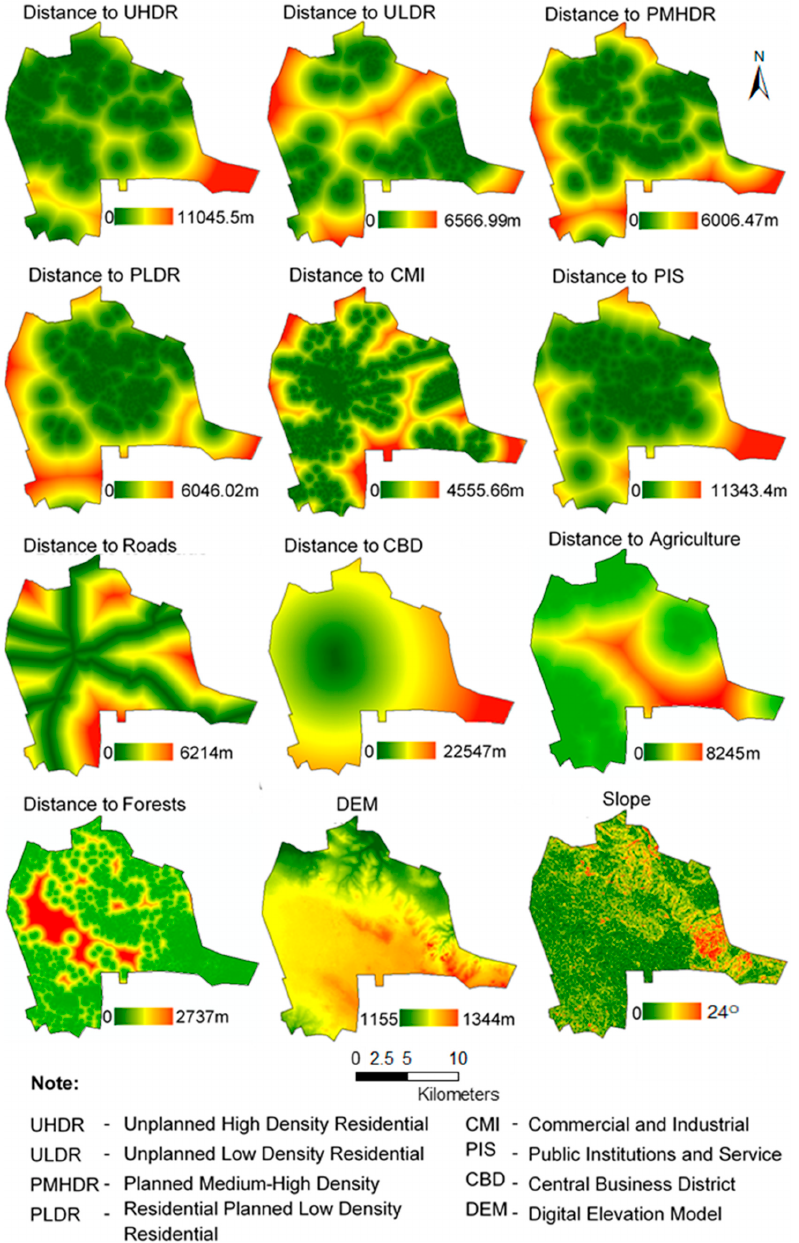
Figure 3. Model driver variables for the intra-urban land-use expansion of Lusaka city for the pe- riod.